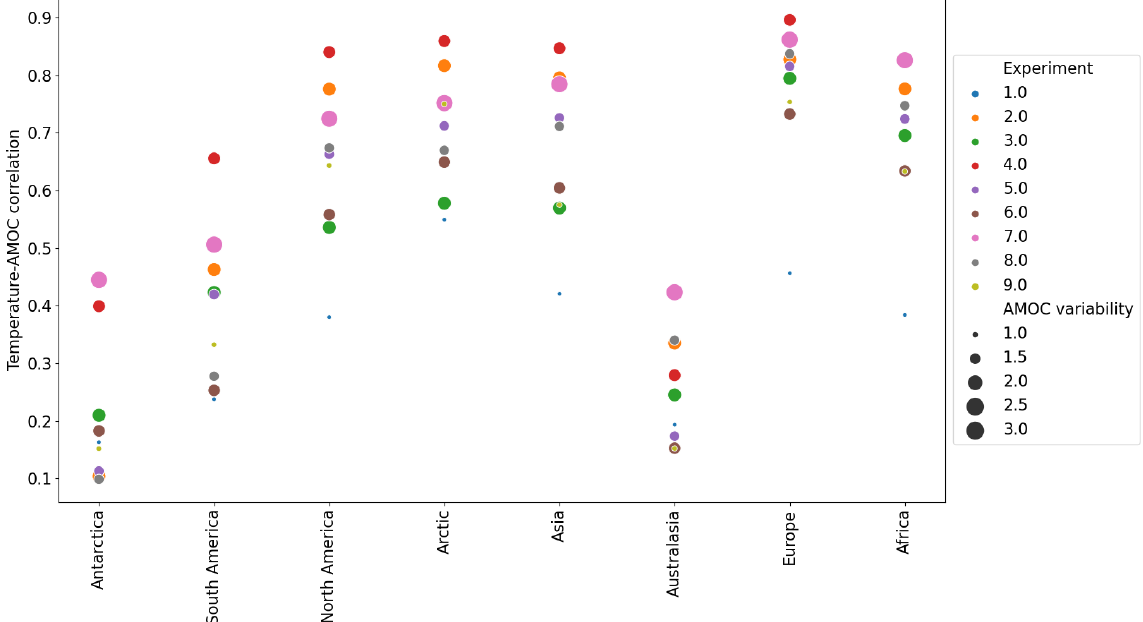
Figure 2. Correlation of continentally averaged temperature time series with AMOC evolution in the i LOVECLIM ensemble. The different experiments are shown in different colours, and the amount of AMOC variability (Sv) in the different experiments is shown by the marker size. These results are lagged correlations per continental time